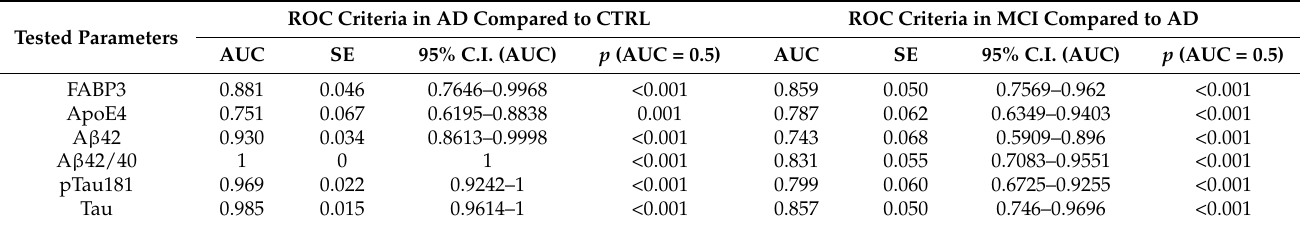
Table 3. AUC of tested parameters in compared groups.